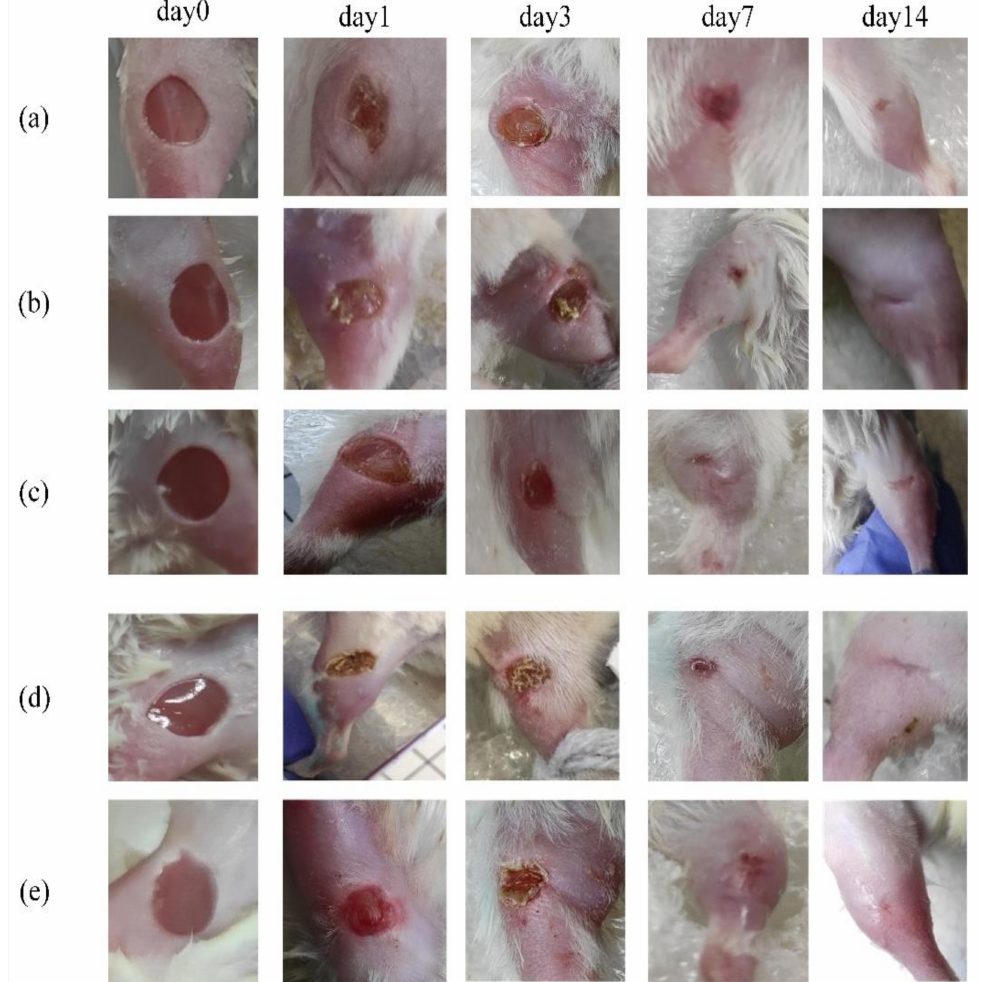
Figure 2. Digital photograph assessment of healing progression from day 0 to day 14: ( a ) con- trol group; ( b ) LDPDT–5-ALA/1 J/cm 2 ; ( c ) LDPDT–5-ALA/4 J/cm 2 ; ( d ) LDPDT–MB/1 J/cm 2 ; ( e ) LDPDT–MB/4 J/cm 2